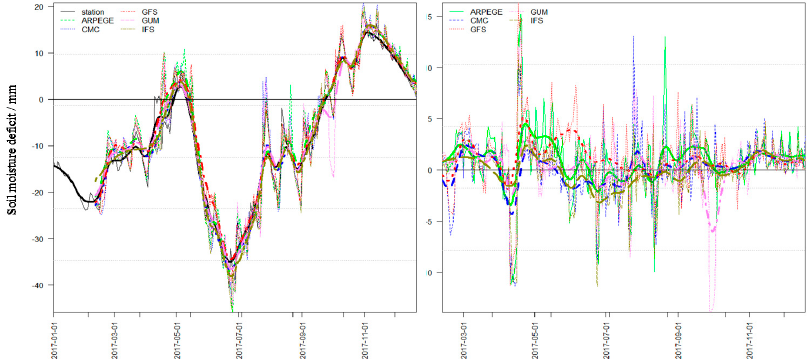
Figure 8. ( Left ) Comparison of the meteorological forecast of the soil moisture deficit in the whole profile (0–100 cm) provided by 5 NWP models for 3 days ahead and reality (black) in the Czech Republic in the year 2017. ( Right ) Differences of the NPW outputs with regard to reference series (reality based on station data interpolated into maps). Thick lines: values smoothed with 30-day low- pass Guassian filter.